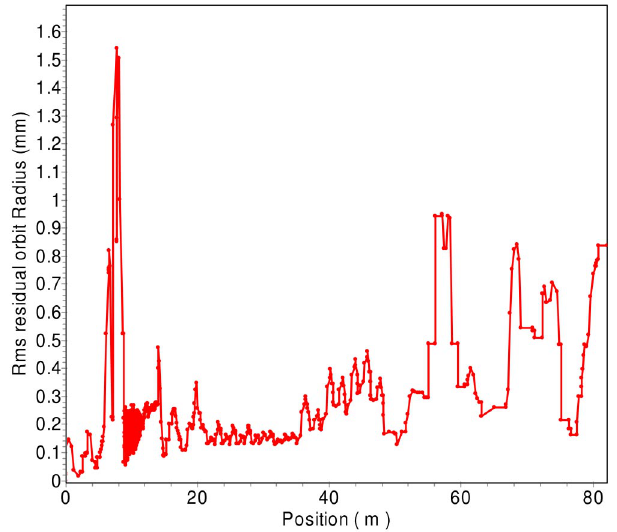
FIG. 15. (Color) rms orbit behavior in the linac.